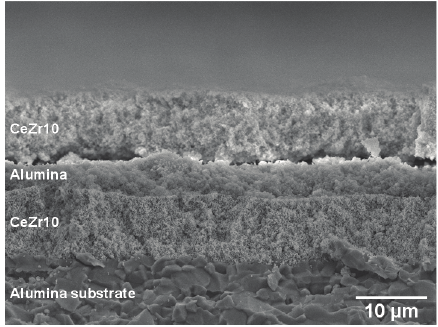
Figure 3. Cross-sectional FE-SEM image of the CeZr10/Al 2 O 3 /CeZr10 layered thick film.